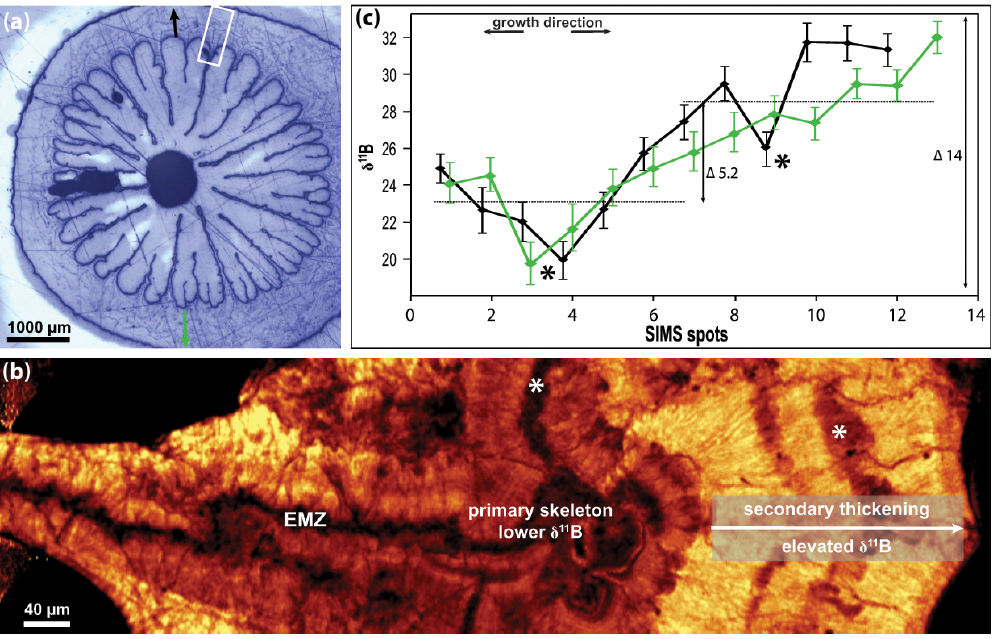
Figure 4. Side branch of Lophelia pertusa cut in transversal plane and prepared for Raman mapping and SIMS analysis. (a) Microscopic image contains the location of the Raman map and the SIMS transects. (b) Raman map of the intensity distribution of the main aragonite peak (symmetric stretch, 1085cm − 1 ) reveals the early mineralization zone (EMZ), the primary skeleton and the area of secondary thickening. Asterisks mark EMZ in the primary skeleton and skeletal areas within the secondary thickening zone of potentially reduced Boron isotopic value (cf. opaque growth bands in Blamart et al., 2007 or 1 ◦ , 2 ◦ nucleation zone in Cohen et al., 2006). (c) δ 11 B measured from inside to the outer coral skeletal rims (transect